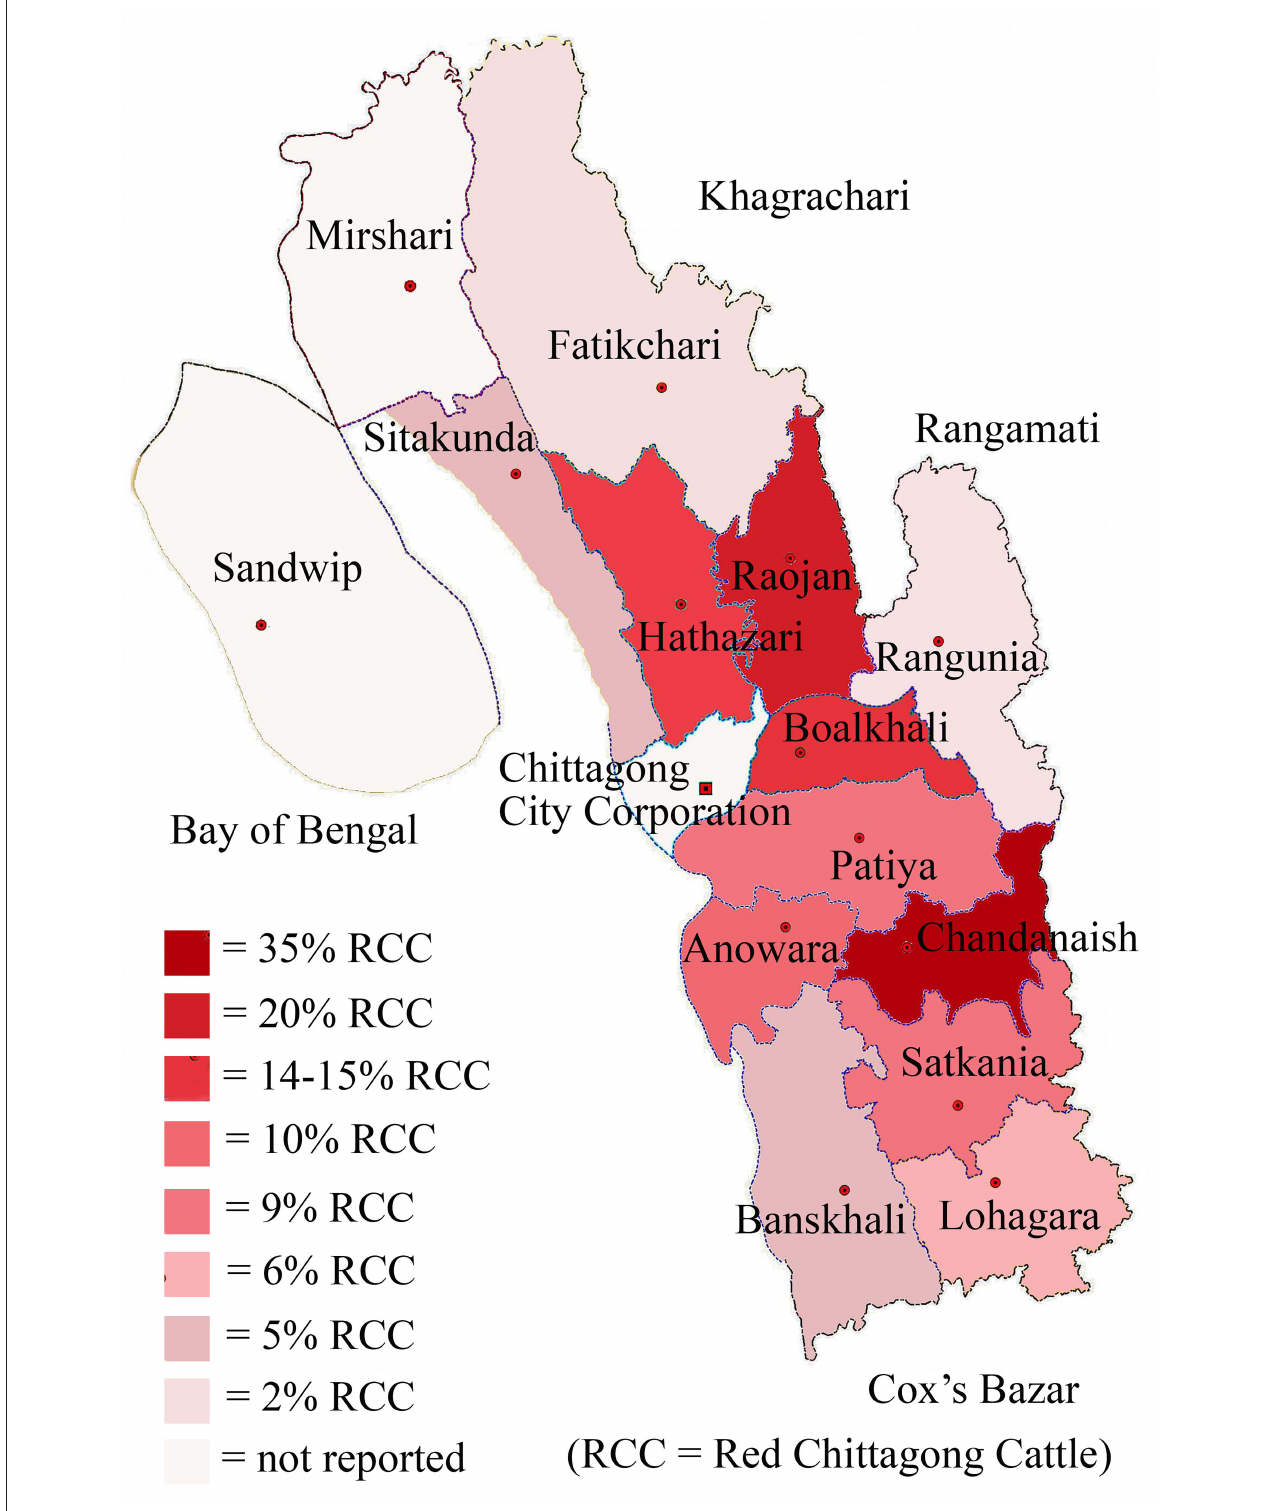
FIGURE 1 | Geographical distribution of Red Chittagong cattle at Chittagong in 2008 [adapted from Huque et al. (2010)].